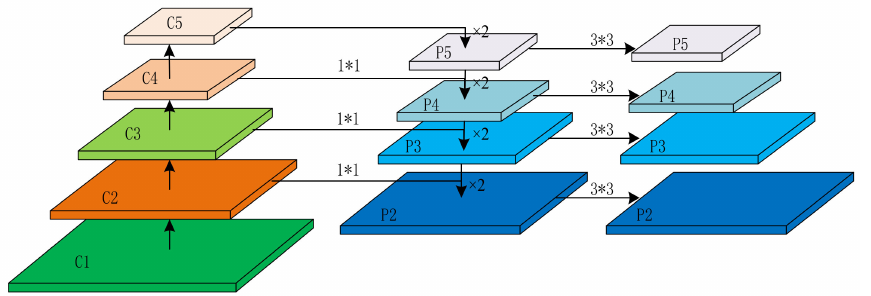
Figure 12. Schematic diagram of the feature pyramid network (FPN) network structure (C is feature channel, P is the channel through lower connection and horizontal connection).